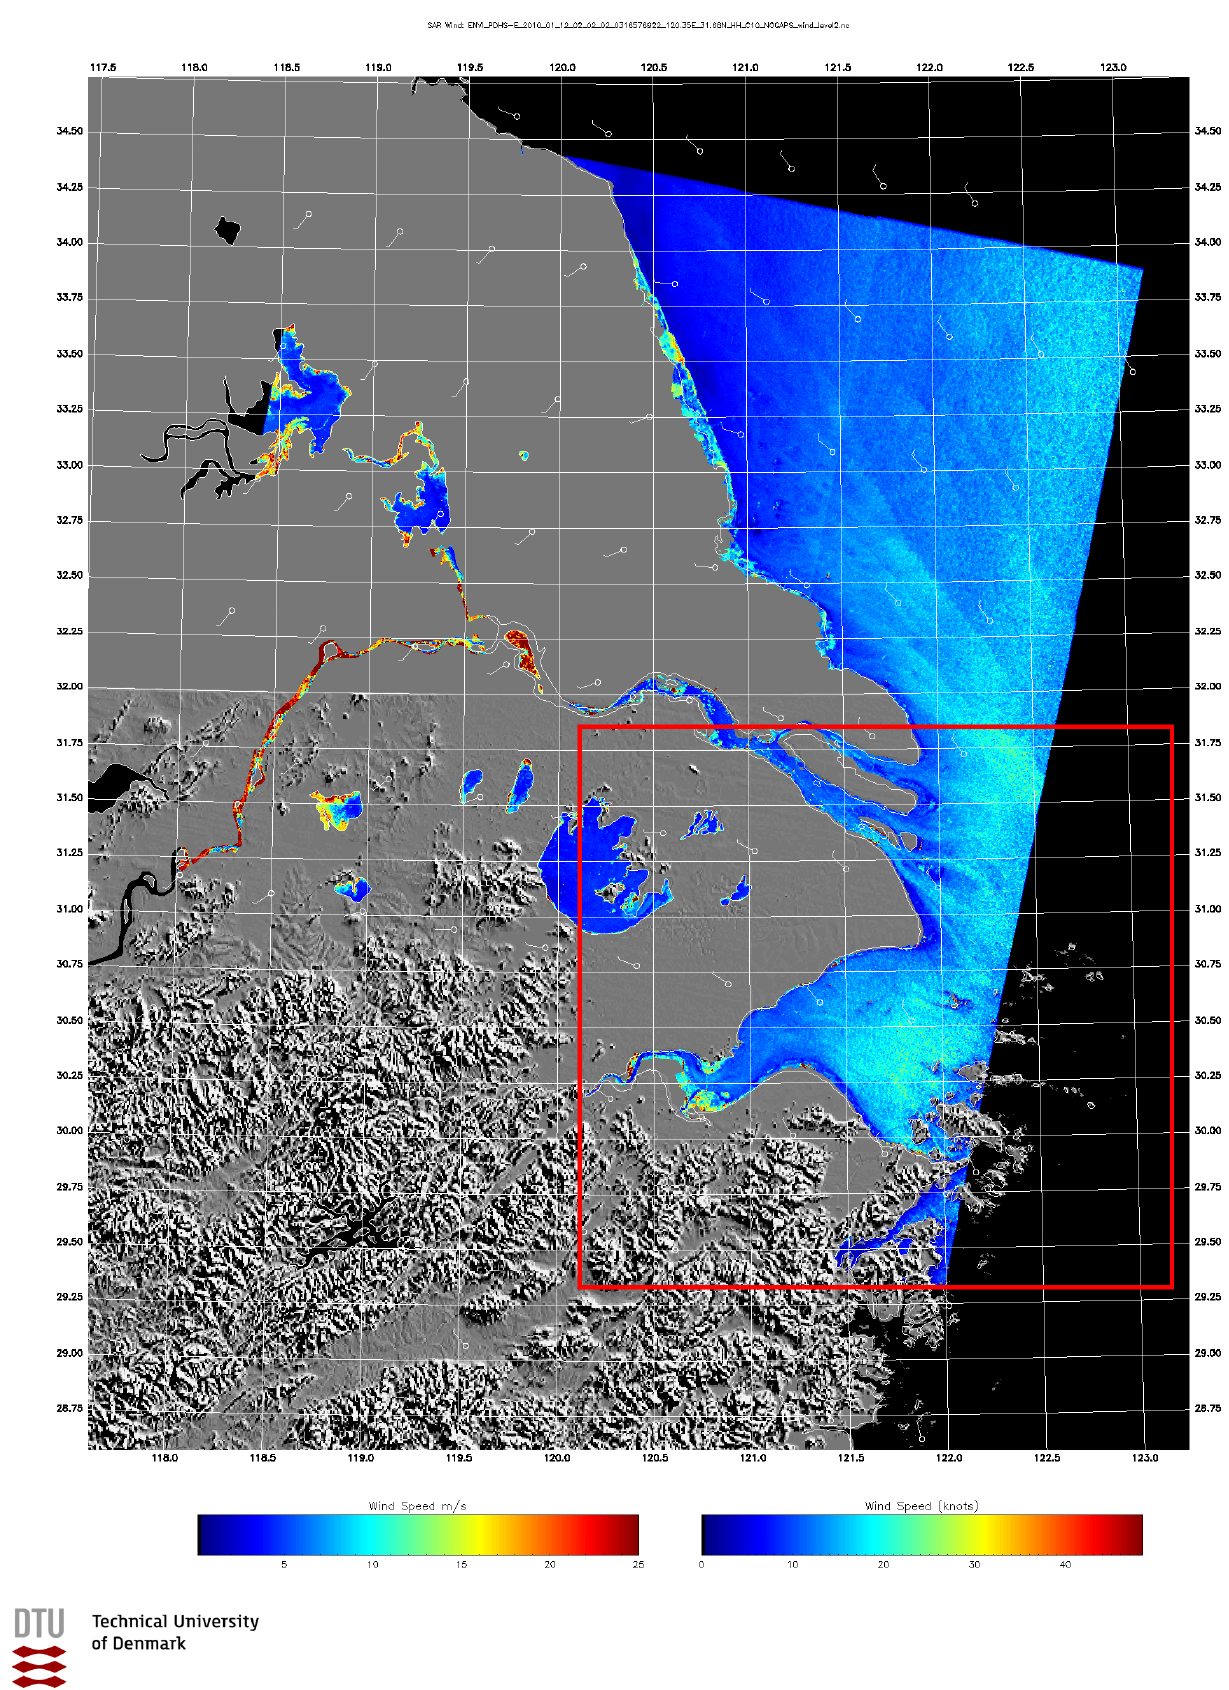
Figure 2. Wind field retrieved from ENVISAT advanced synthetic aperture radar (ASAR) Wide Swath Mode (WSM) data for 12 January 2010 at 02:02